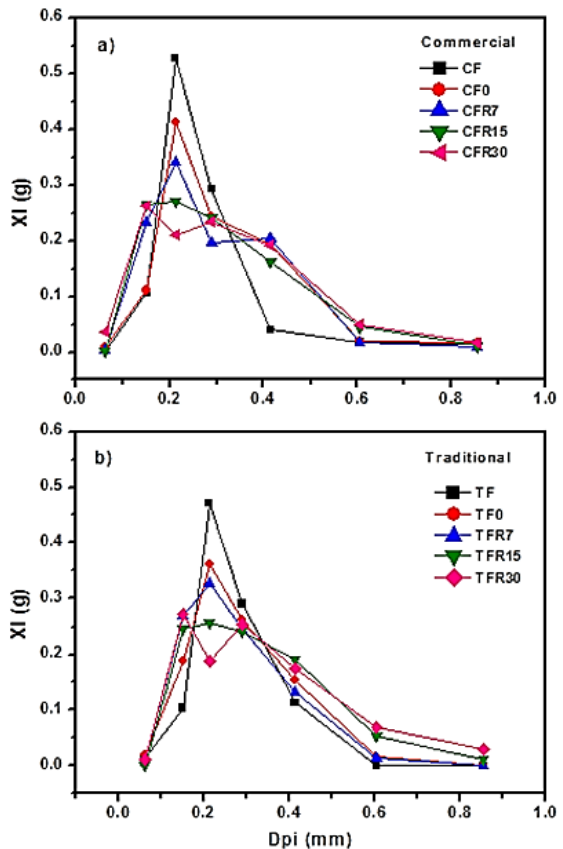
Figure 2. Particle size distribution of ( a ) nixtamalized corn flour and corn tortilla flours obtained by the industrial (commercial) method, ( b ) nixtamalized corn flour and corn tortilla flours obtained by the traditional method without refrigeration and stored in refrigeration (4 ◦ C) at di ff erent periods of time. TF = Nixtamal flour made with the traditional method, CF = Nixtamalized corn flour made with the industrial (commercial) method, TF0 = traditional corn tortilla flour without refrigerated storage, CF0 = commercial corn tortilla flour without refrigerated storage, TFR(7, 15, 30) = traditional corn tortilla flours with refrigerated storage (4 ◦ C) during 7, 15, and 30 days, respectively, CFR(7, 15, 30) = commercial corn tortilla flours with refrigerated storage (4 ◦ C) during 7, 15, and 30 days,